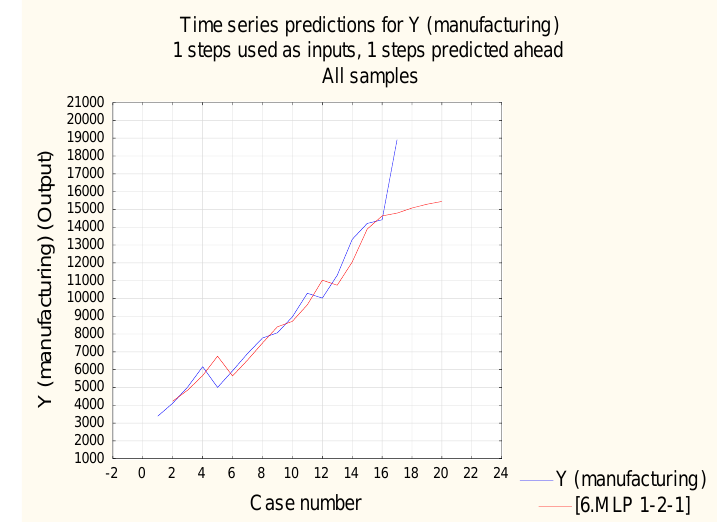
Figure 6. Projection the Y manuf. for 7 years ahead.